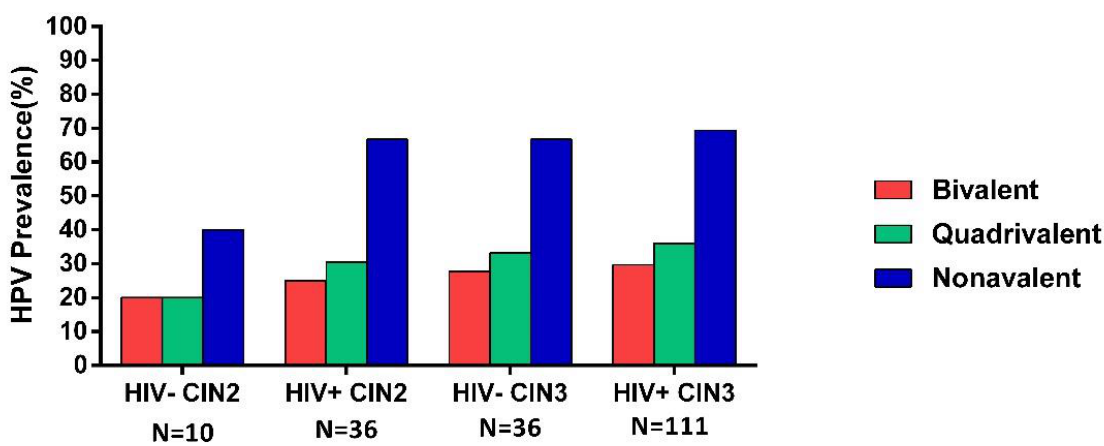
Figure 5. Prevalence of HPV vaccine types according to CIN2/3 and HIV status.